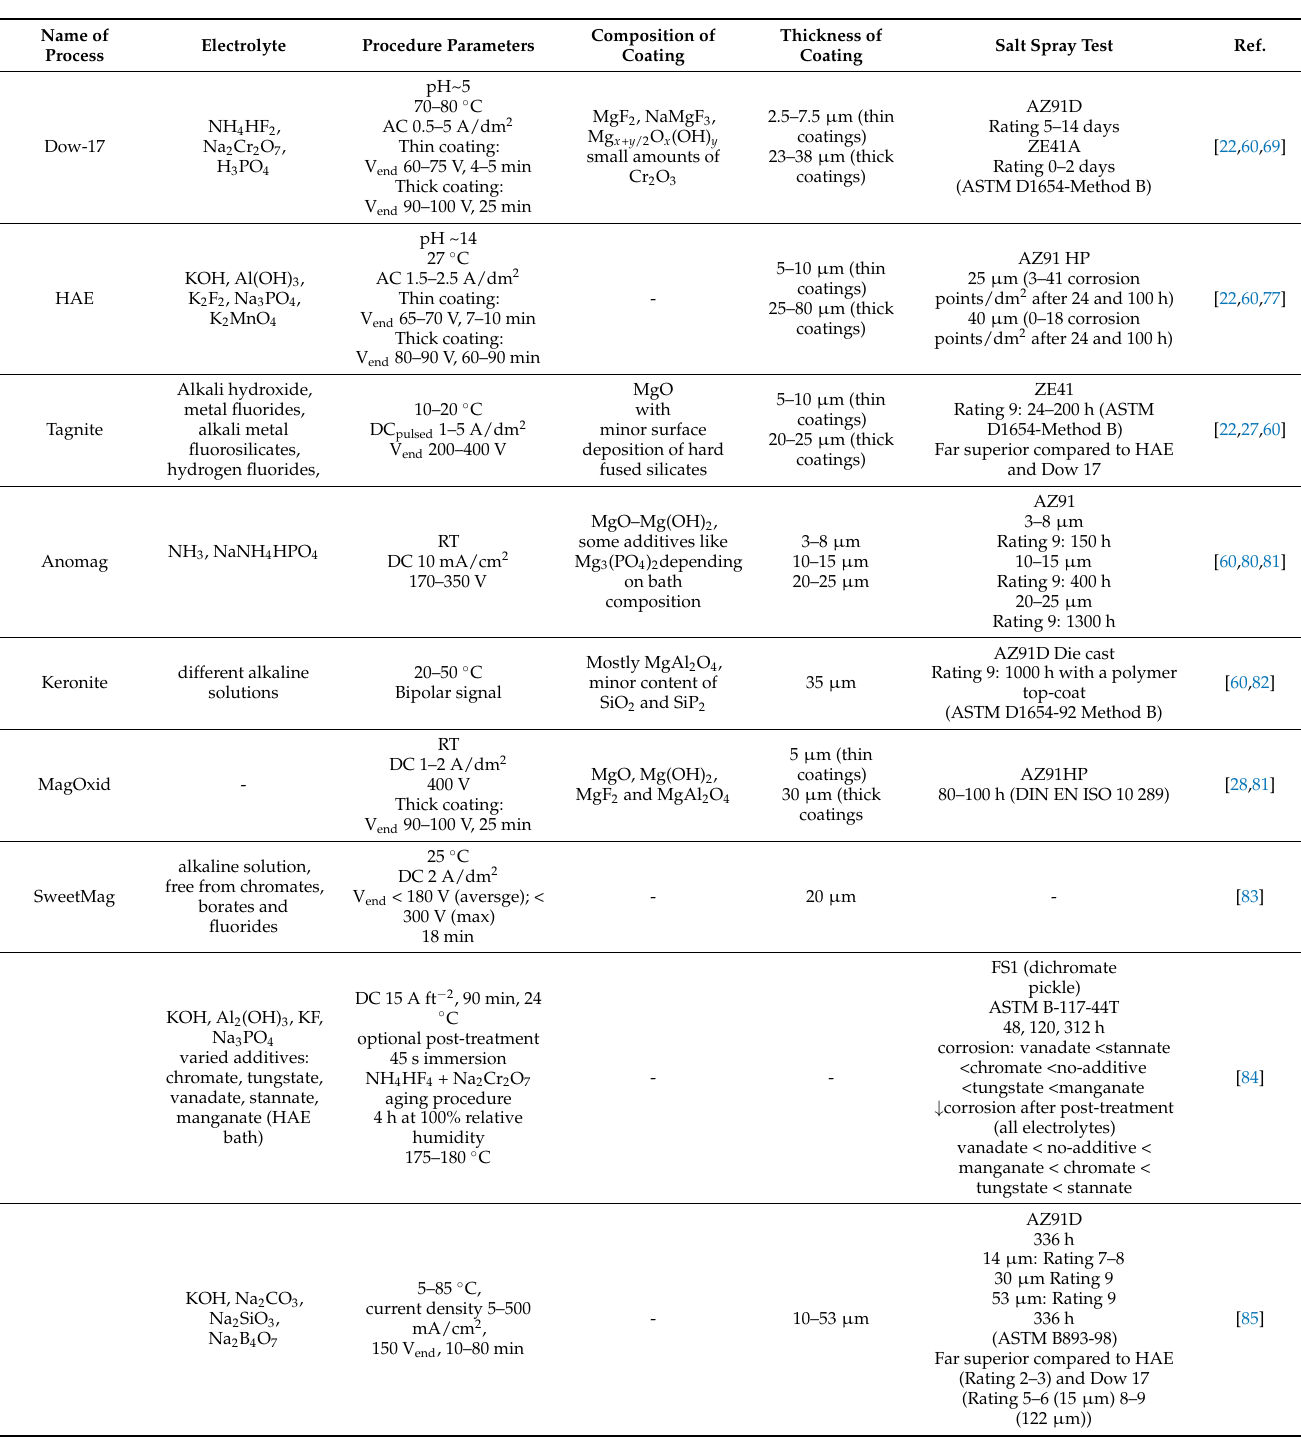
Table 1. Summary of the conditions and corrosion properties of commercial anodic coating treatments and selected research